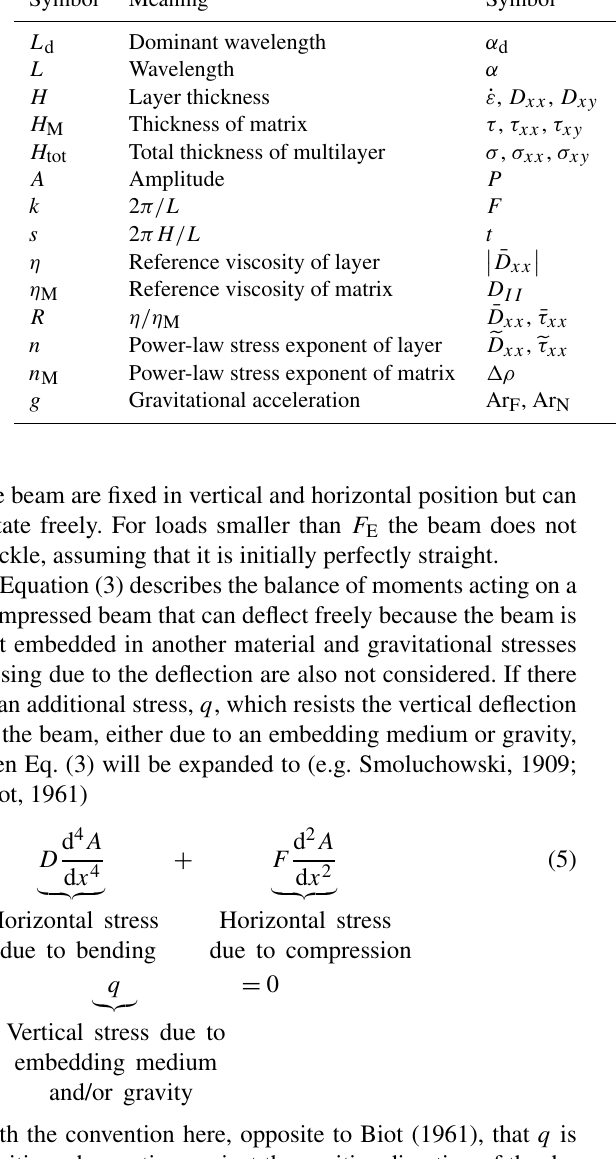
Table 1. Frequently used symbols and their consistent meaning throughout the text. Symbol Meaning Symbol Meaning L d Dominant wavelength Wavelength ˙ ε , D xx , D